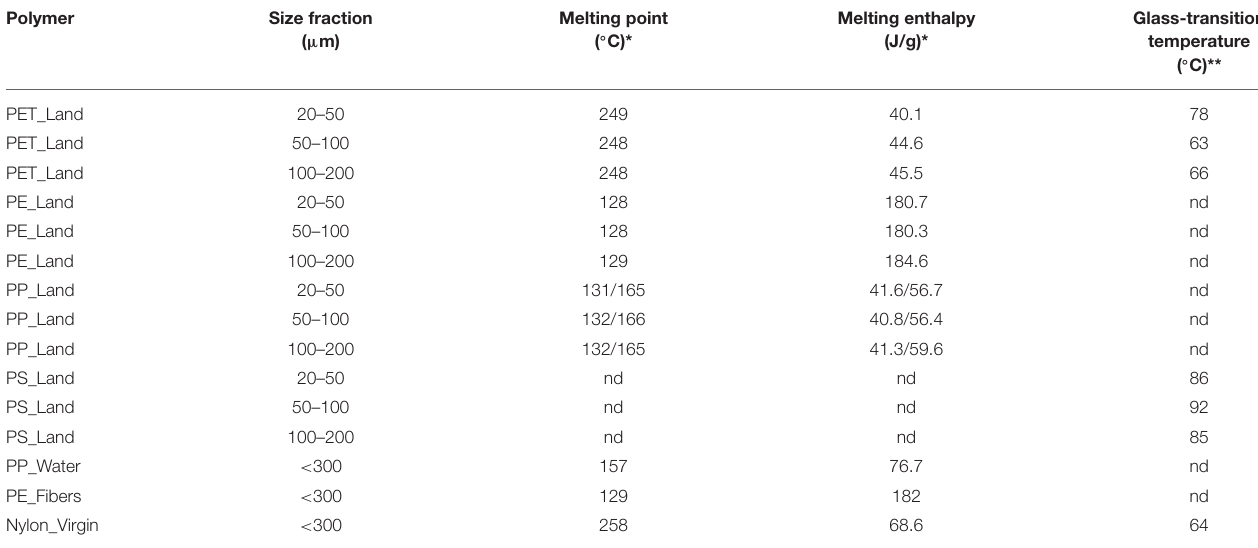
TABLE 3 | DSC-derived thermal properties.